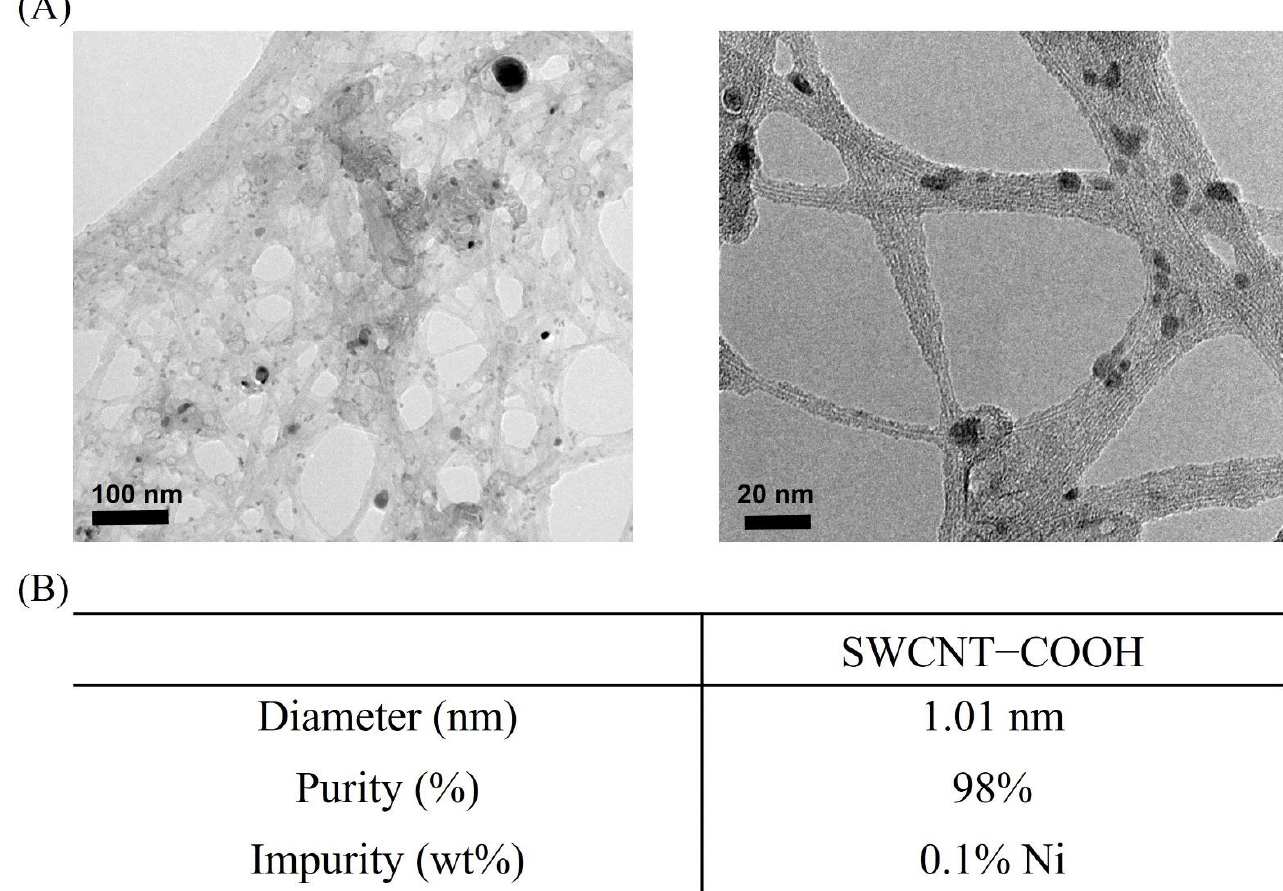
Figure 1. Physiochemical characterization of SWCNTs−COOH in K-medium. ( A ) TEM images of SWCNTs−COOH dispersed in the K-medium with the observed presence of amorphous carbon. ( B ) Summarized properties of the SWCNTs−COOH .